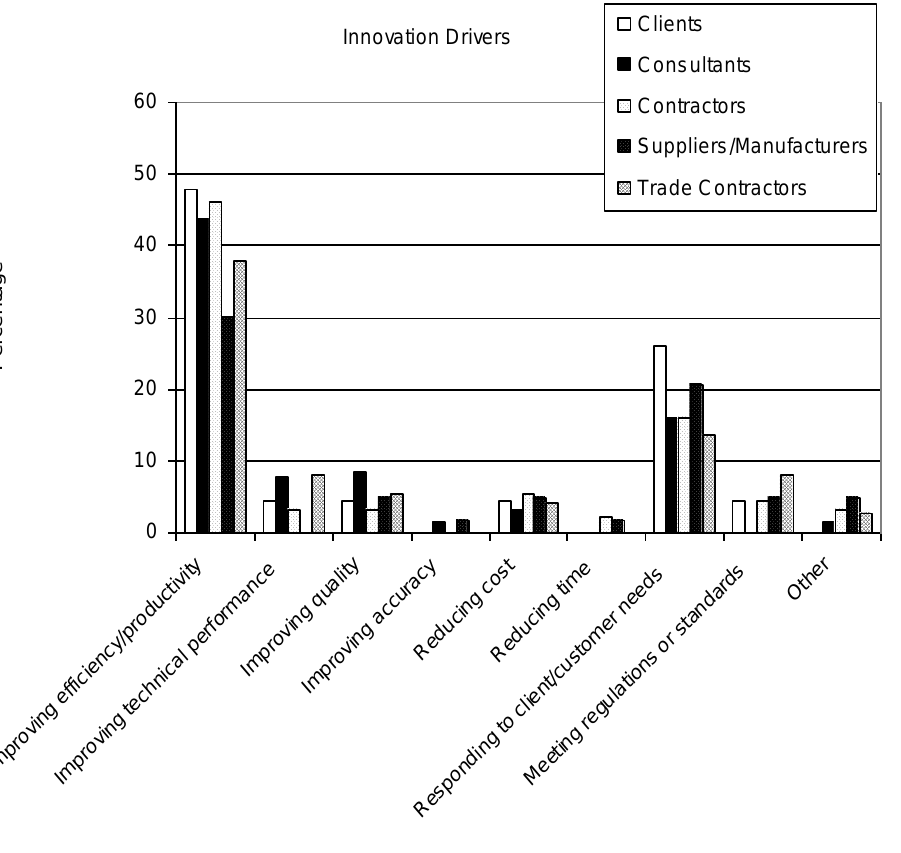
Figure 3 : Main Innovation Drivers per Sector Innovation Obstacles